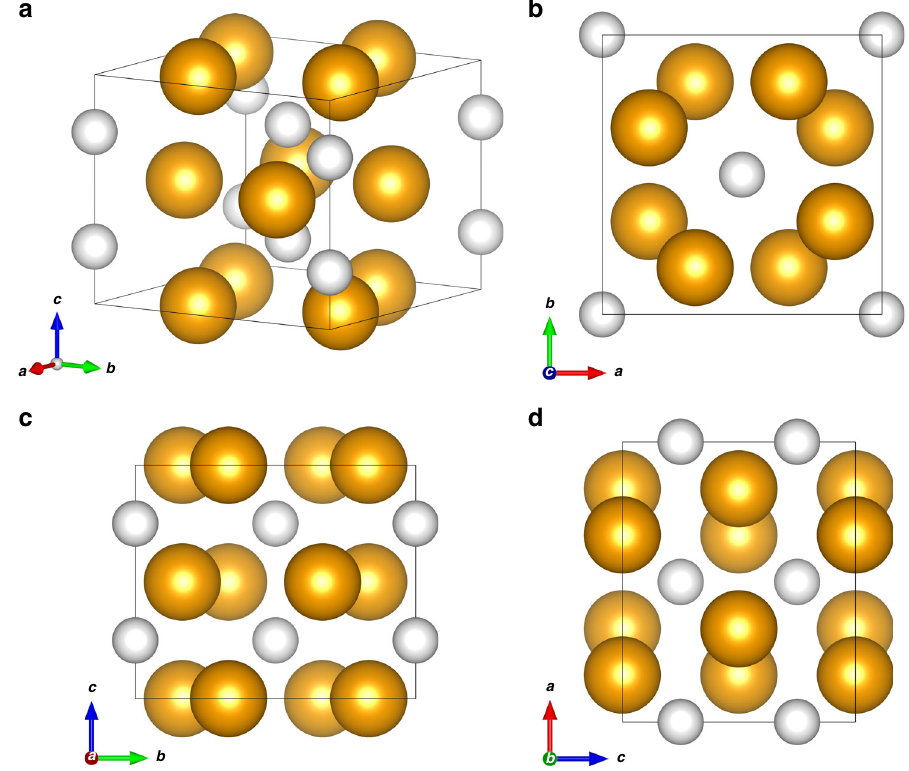
Fig. 4 Crystal structure of the (PH 3 ) 2 H 2 vdW compound. Crystal structure of the (PH 3 ) 2 H 2 vdW compound at 5.5 GPa and room T ( a ) with views along the c ( b ), a ( c ), and b ( d ) crystal axes. The orange spheres represent the PH 3 molecules, whereas the white spheres represent the H 2 molecules. The size of the spheres has been drawn by estimating their radius as the sum of the P – H bond length (1.421 Å ) 2 and H van der Waals radius (1.20 Å ) 49 in the case of PH 3 (2.62 Å ) and as the sum of the H van der Waals radius (1.20 Å ) 49 and half of the H – H distance (0.742 Å ) 74 in the case of H 2 (1.571 Å